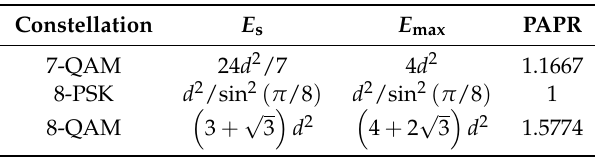
Table 2. PAPRs of three constellations.